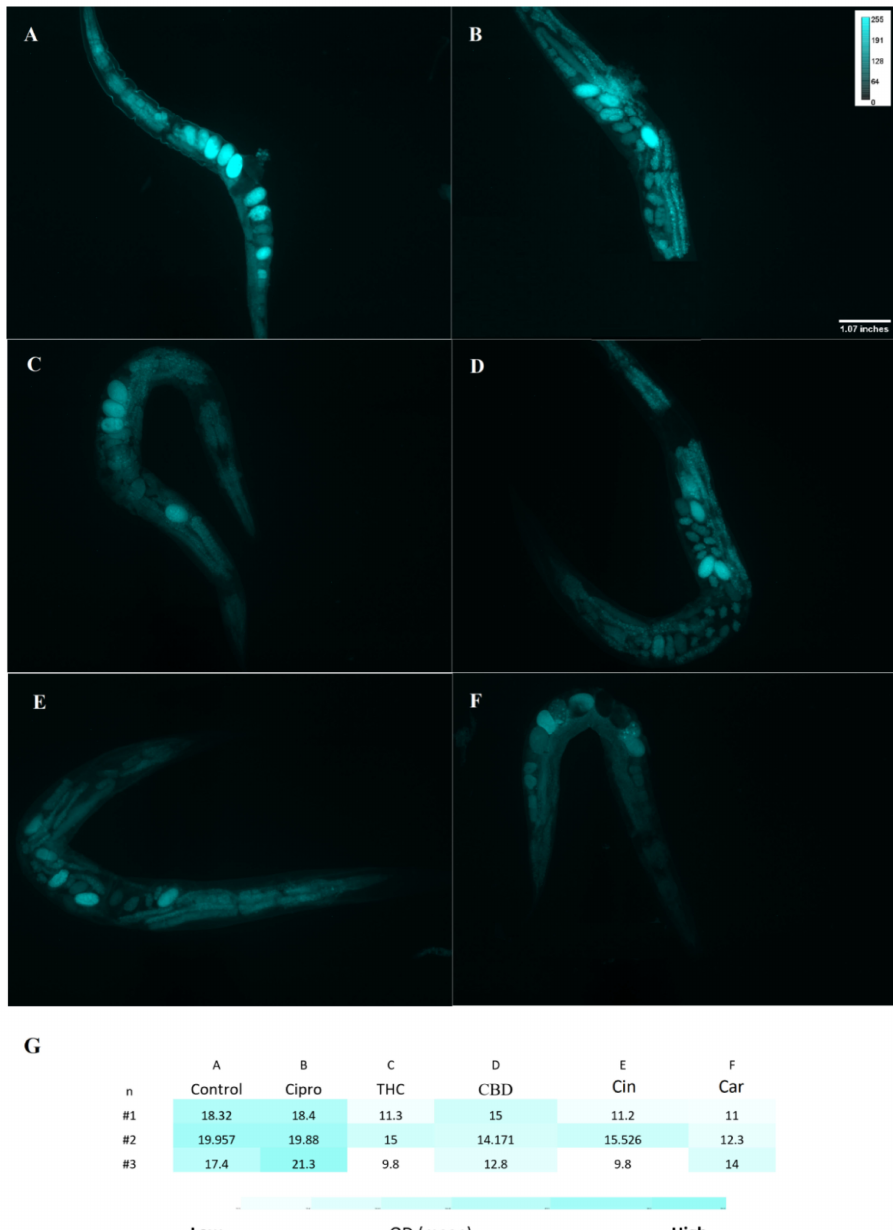
Figure 5. DCFH-DA staining for reactive oxygen species (ROS) level. Fluorescence intensity of all C. elegans ROS levels was measured after exposure to control (PBS) ( A ), ciprofloxacin ( B ), THC ( C ), CBD ( D ), cinnamaldehyde ( E ), and carvacrol ( F ) by DCFH-DA probe. Heatmap on ROS level of C. elegans in the treated and untreated groups showed in panel ( G ). n = trial